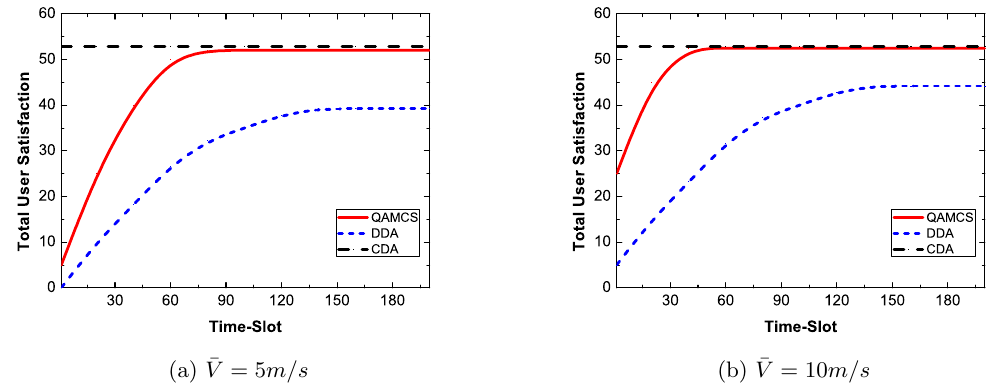
Figure 1: Performance comparison in terms of total user satisfaction when U = 40 .